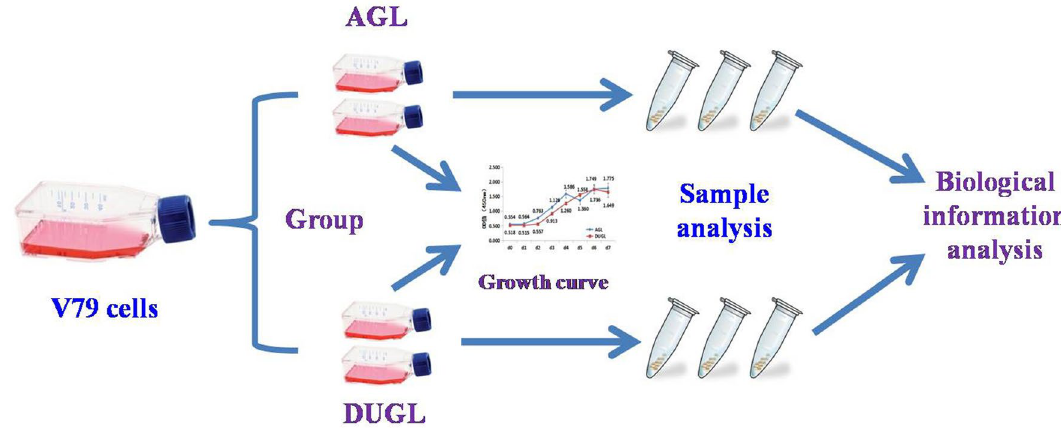
Figure 8. Flow chart showing the study design. AGL above-ground laboratory, DUGL deep underground